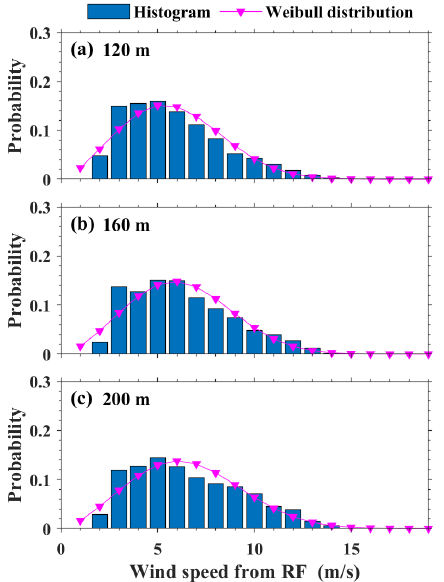
Figure 8. Probability distribution and Weibull distribution of (a) WS 120 , (b) WS 160 , and (c) WS 200 from 1 May 2018 to 31 August 2020. The blue bar and pink lines represent occurrence probability and Weibull distributions, respectively.